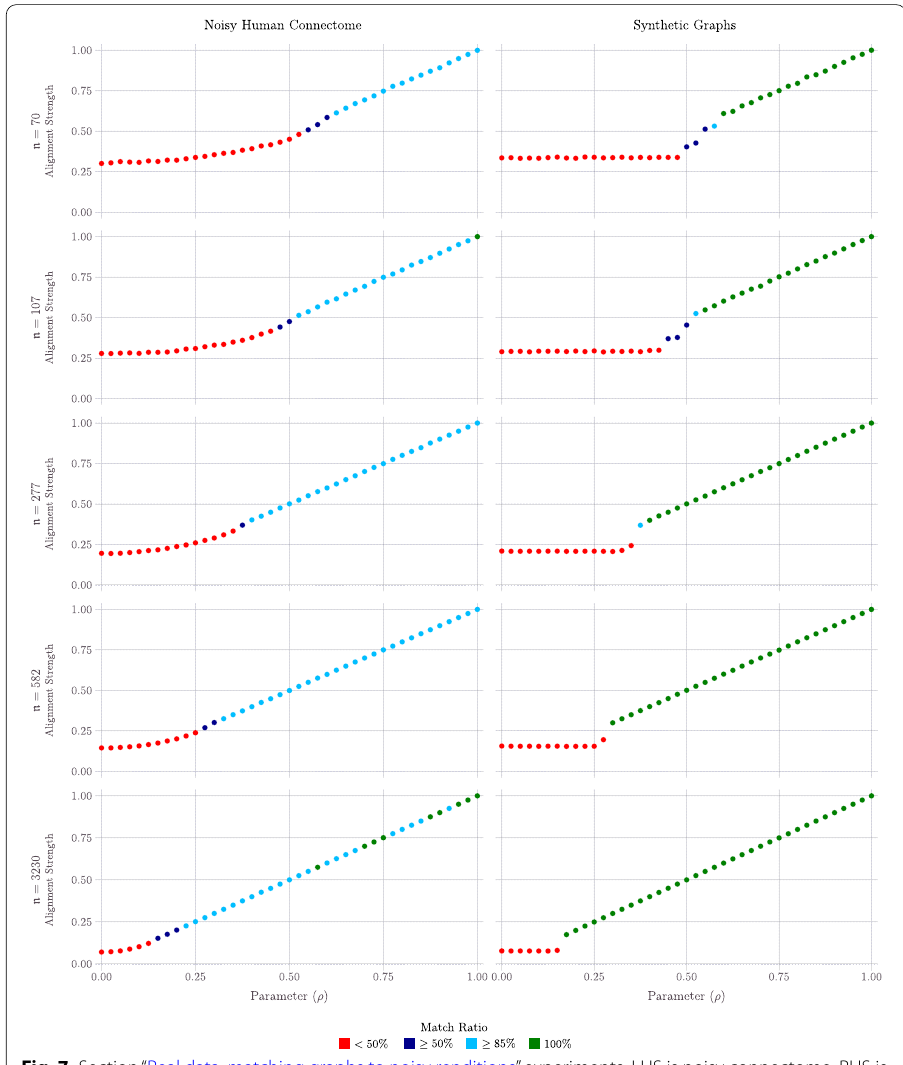
Fig. 7 Section “Real data; matching graphs to noisy renditions” experiments; LHS is noisy connectome, RHS is corresponding